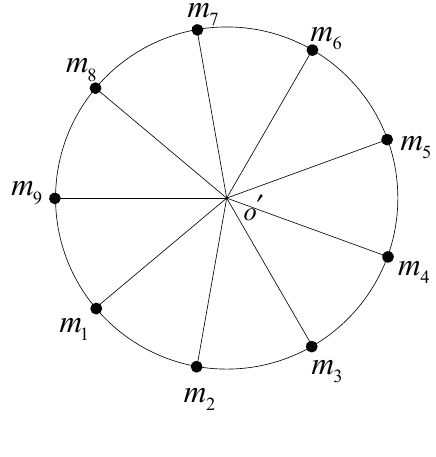
Figure A1. The top view from point o to the direction of the vector S